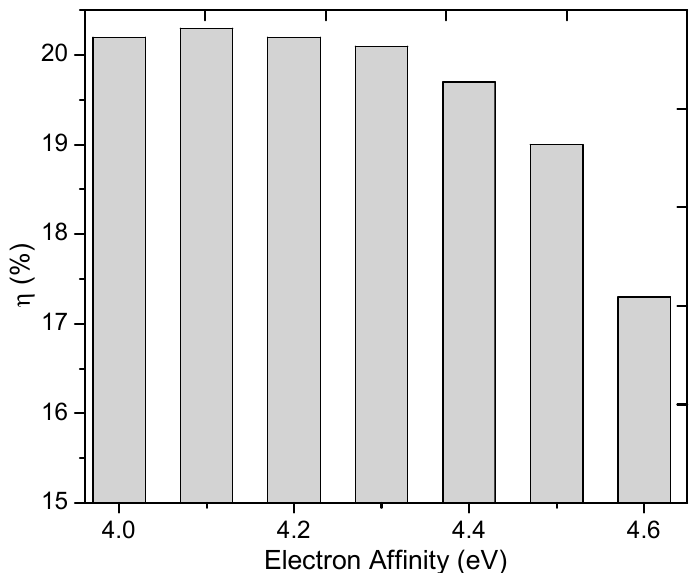
Figure 3. Influence of electron affinity of ZnO (bandgap: 3.27 eV) on the efficiency of n-ZnO/p-Si heterojunction solar cell using PC1D simulations.